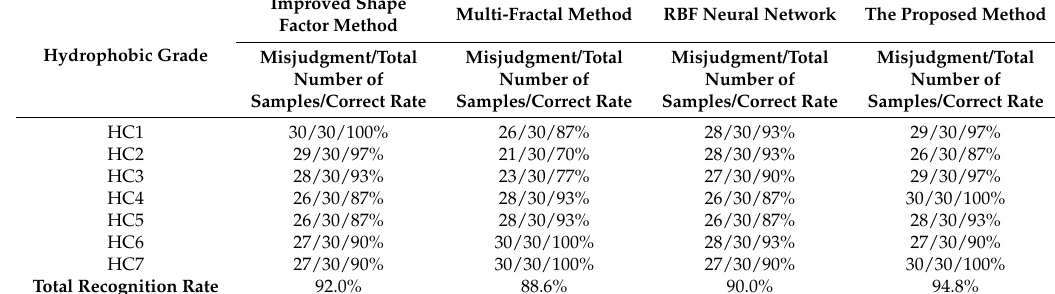
Table 5. Comparison of different classification methods.